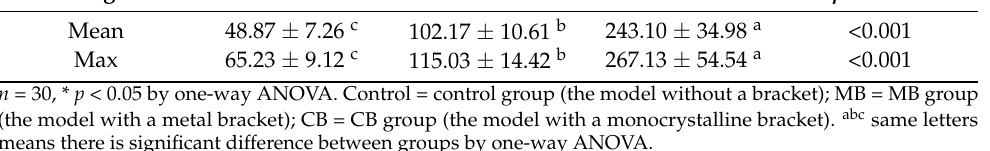
Table 1. Comparison of intraoral scanner recording time according to orthodontic brackets (unit: s). Recoding